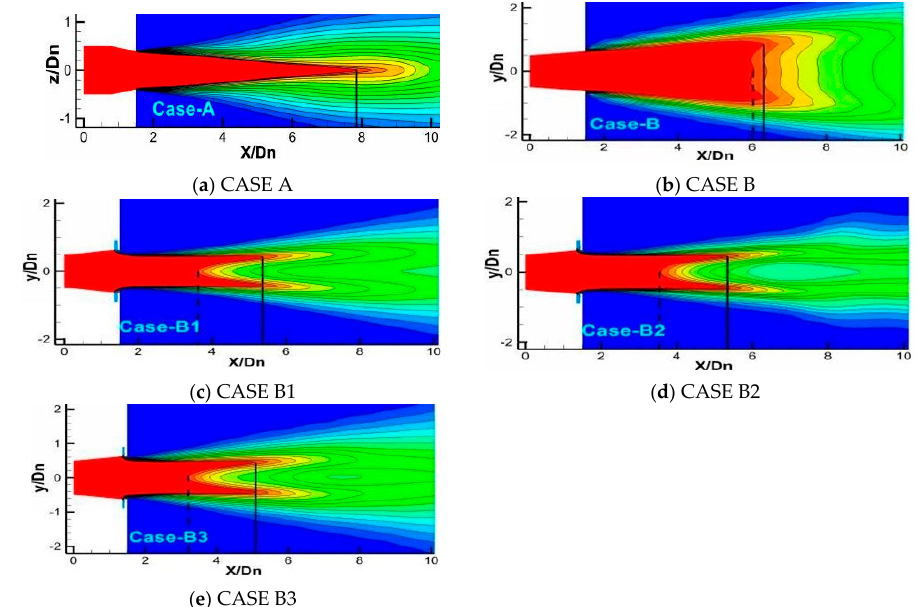
Figure 9. Mean temperature contour on the horizontal plane. Figure 10 shows the time-averaged temperature distribution of the axial sections for different cases. Compared with CASE A (Figure 10a), the temperature contour map of CASE B (Figure 10b) showed a flatter, rectangular profile, which resulted in a larger contacting area with ambient gas and a stronger mixing ability for the ambient gas. In Figure 10c, circumferential four-strand transverse jets are introduced. The high-temperature zones in CASE B1 showed four concave zones in the middle of four edges near the nozzle exit, and in the downstream field, the hot jet expanded in both the vertical and the horizontal plane under the extrusion of the transverse jets. The trans- verse jets significantly increased the mixing between hot jet and ambient gas, which truncated the high-temperature zone downstream, on the vertical and horizontal planes. ( a ) CASE-A